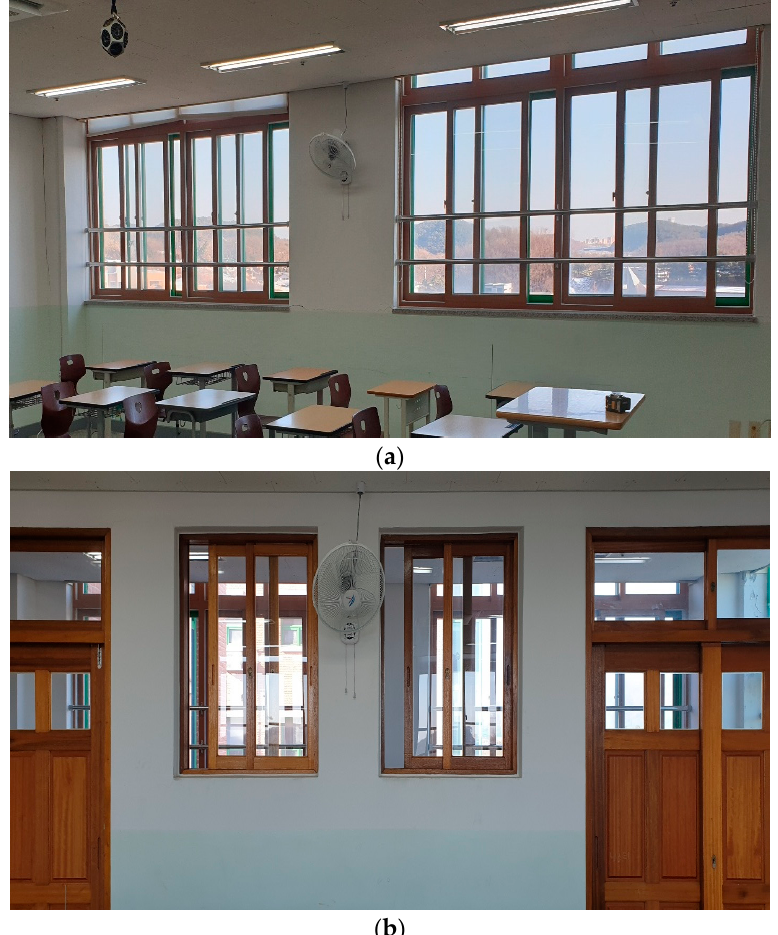
Figure 2. Photographs of the windows in the classroom: ( a ) outside windows; ( b ) corridor windows (and showing the closed front and rear entrances to the classroom).